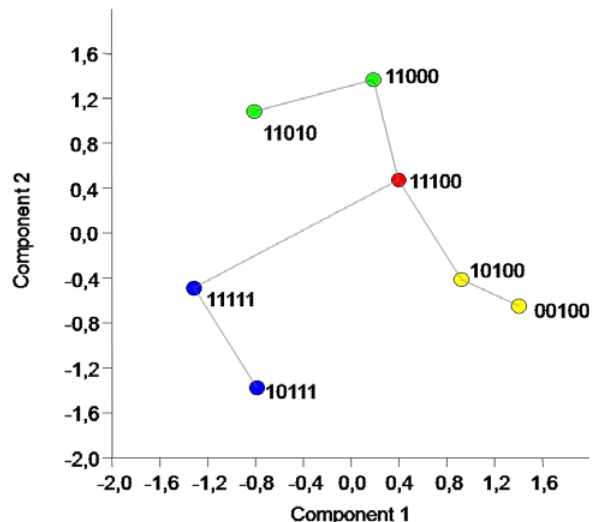
Figure 2. Principal component analysis of seven haplo- types showing a Minimal Spanning Tree to indicate the shortest possible set of connected lines linking all points. Symbols represent: cluster A, cluster B, cluster C, and cluster D in the cluster